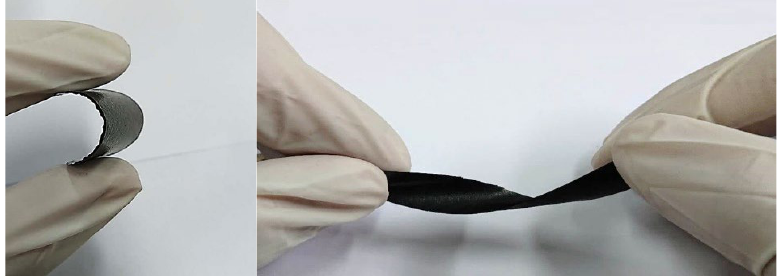
Figure 4. Bending and twisting tests of Buckypapers.